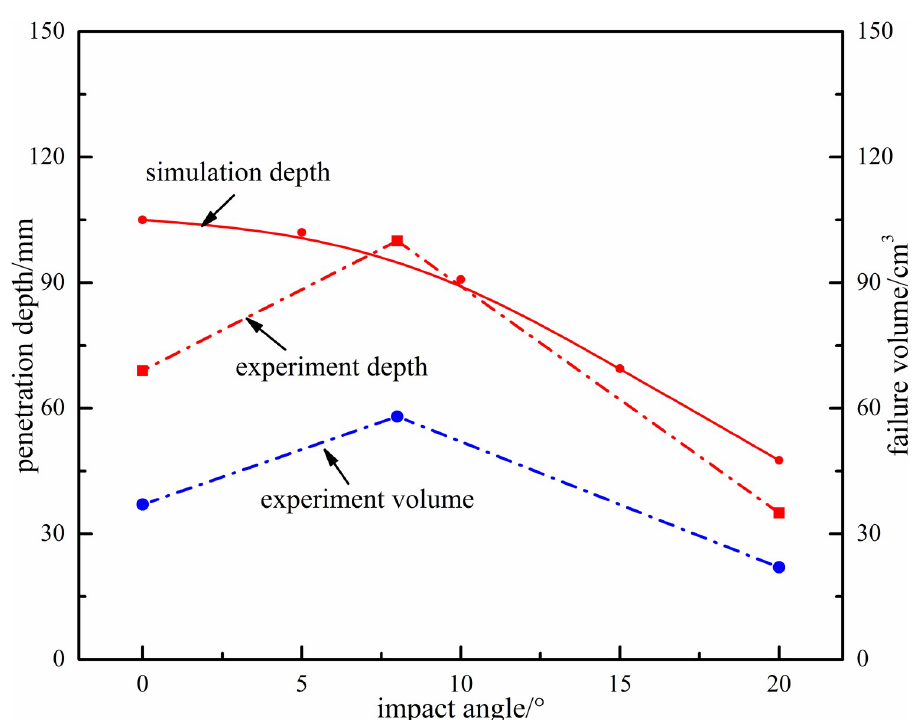
Fig 14. The effect of impact angle on failure volume and penetration